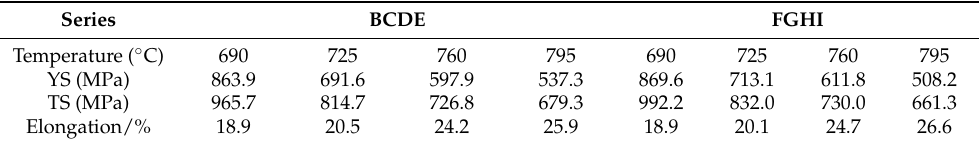
Table 4. Mechanical properties of 0.004Zr alloys.